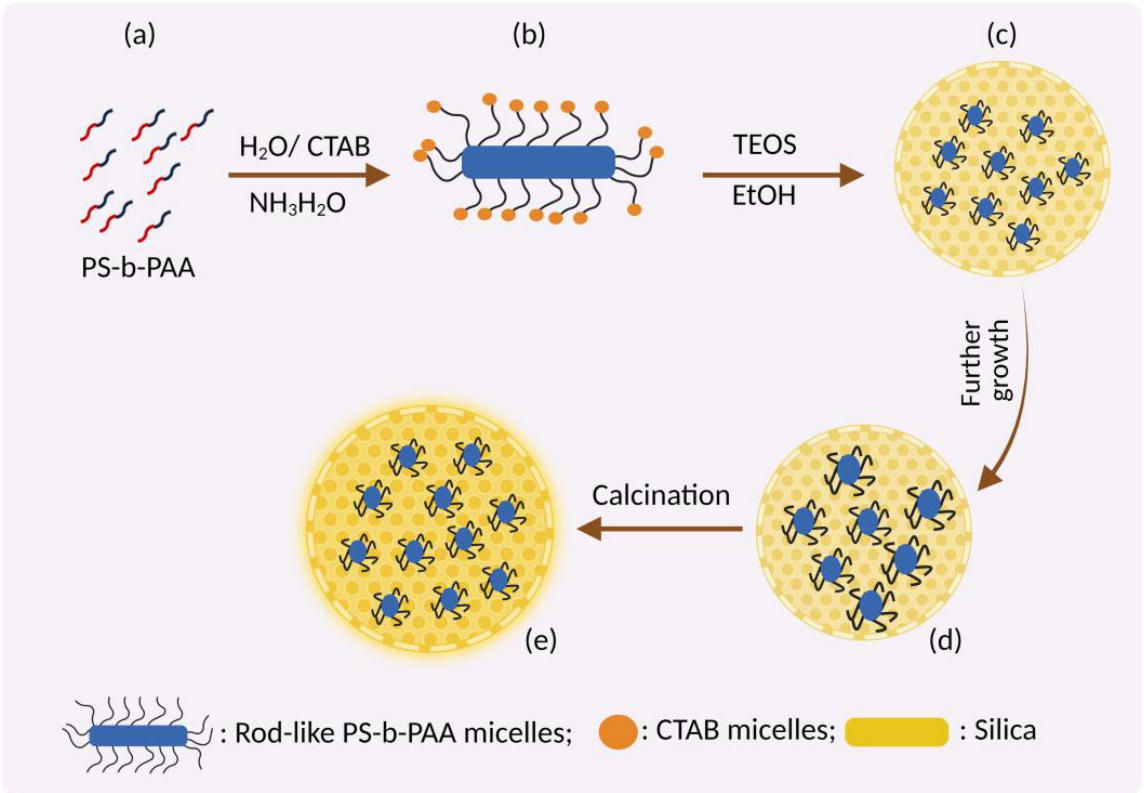
Figure 4. Formation of MSNs by Stober’s method. ( a ) Amphiphilic block copolymer (polystyrene-b- poly(acrylic acid), PS-b-PAA) and CTAB as co-templates in aqueous ammonia solution; ( b ) For- mation of composite rod-like micelles due to electrostatic interaction between CTA+ and PAA; ( c ) Formation of core part by deposition of silicate of TEOS on rod-like micelles of CTAB-coated PS-b- PAA; ( d ) Dual mesoporous silica nanoparticles by self-assembly of TEOS with CTAB; ( e ) Calcination forming the final core-shell dual mesoporous silica spheres. (Figure created using BioRender.com; accessed on 2 December 2022).